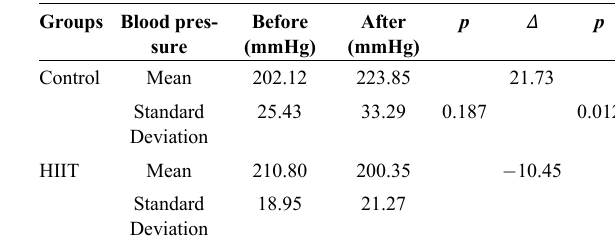
Comparison between means in different groups of animals after eight weeks. Analysis of Variance test - ANOVA with Tukey post-test. HIIT: High-Intensity Interval Training. Variation in systolic blood pressure ∆ : final value - initial value. Control Group (SHR rats, n = 10). HIIT train- ing Group (SHR rats, n =